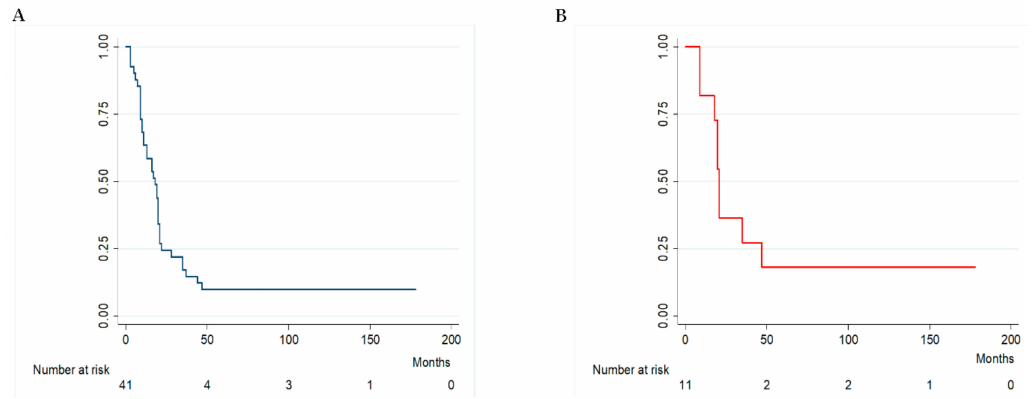
Figure 1. Kaplan-Meyer survival. ( A ) overall; ( B ) 11 wild-type BRAF patients not eligible for check-point therapy or non-responsive for progression or adverse events.